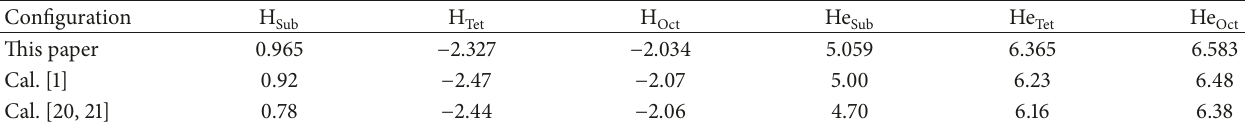
Table 2: Summary of the formation energy of the single defect in W.